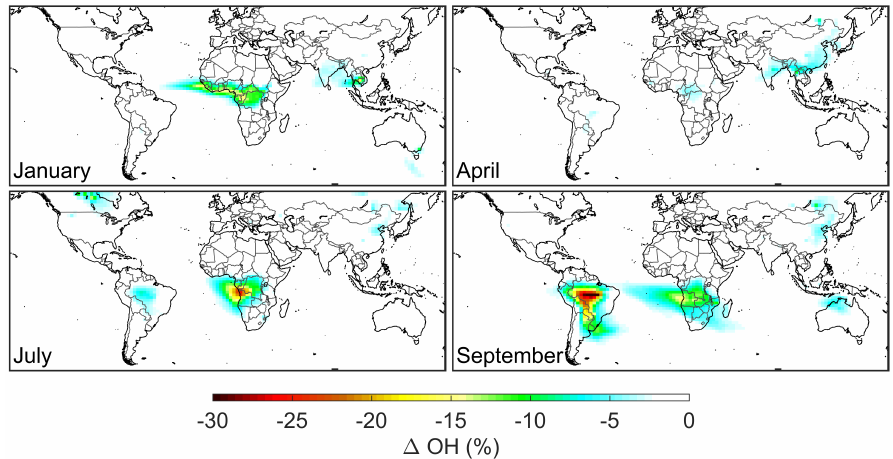
Figure 5. Percent difference between OH concentrations in the lower troposphere from a GEOS-Chem simulation including absorbing BrC minus a simulation without BrC. The values are monthly means for January, April, July, and September